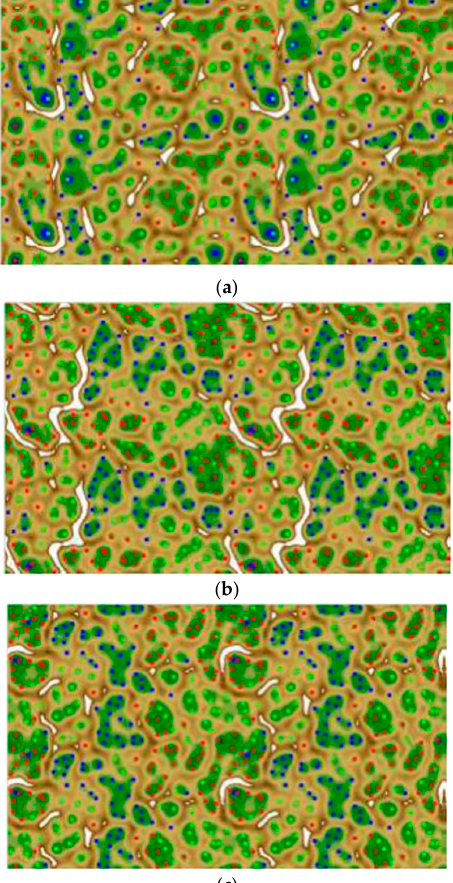
Figure 2. Heatmaps of the U-Matrix with the colored clusters of local regions generated with the P-Matrix. All data points with the same color belong to one cluster, red for K/S selectives, green for S/K selectives, and blue for KS non-selectives. Data points with different colors belong to different clusters. All clusters are lying in regions with small distances between the data points, and are surrounded by regions with large distances. ( a ) BAPS ( b ) MACCS and ( c ) Combined